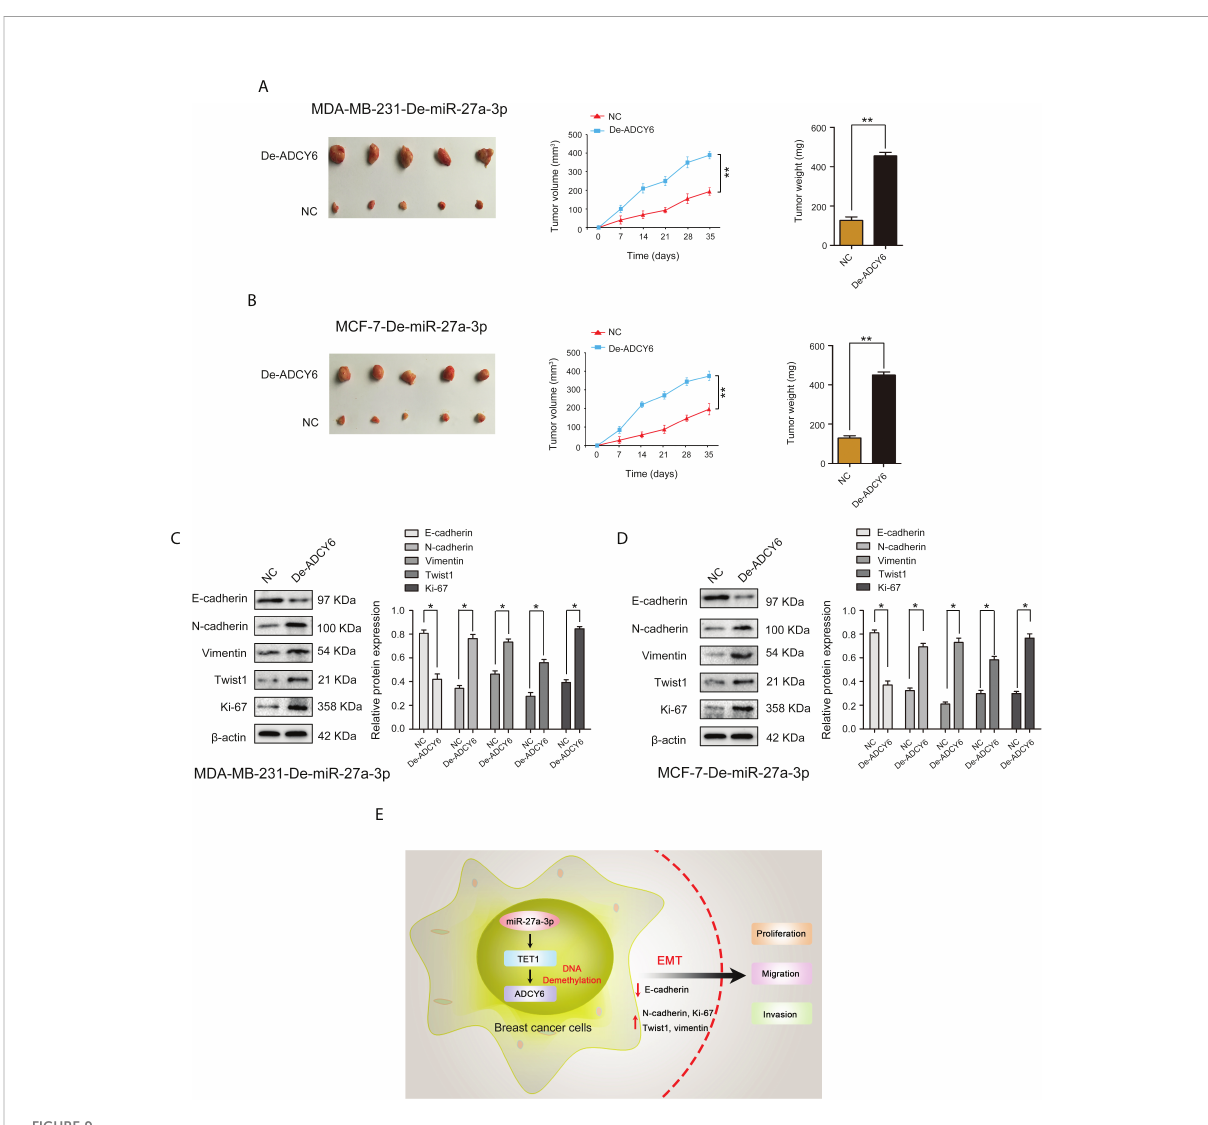
FIGURE 9 ADCY6 ameliorates the promoting effect of miR-27a-3p on BCa tumorigenicity. (A) The tumor volume and weight in vivo in each group detected by nude mouse tumor xenograft assay of MDA-MB-231-De-miR-27a-3p cells after decreased the expression of ADCY6. **p < 0.01 versus controls. (B) The tumor volume and weight in vivo in each group detected by nude mouse tumor xenograft assay of MCF-7-De-miR- 27a-3p cells after decreased the expression of ADCY6. **p < 0.01 versus controls. (C) Protein expression of EMT components, including: